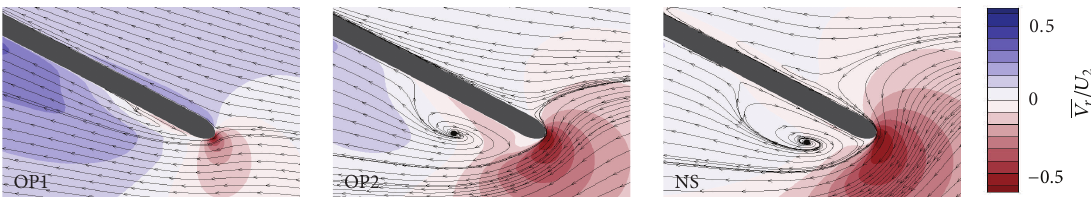
Figure 12: Time-averaged reduced radial velocity contours and streamlines, at 90% span and near the vane leading edge, for the three operating points.